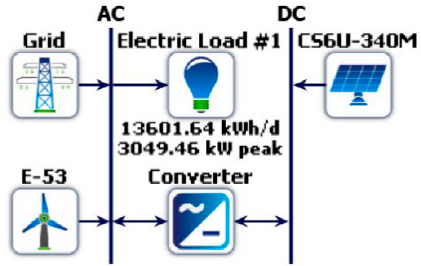
Figure 10. System schematic of Hybrid Solar Wind Energy System in HomerPro.